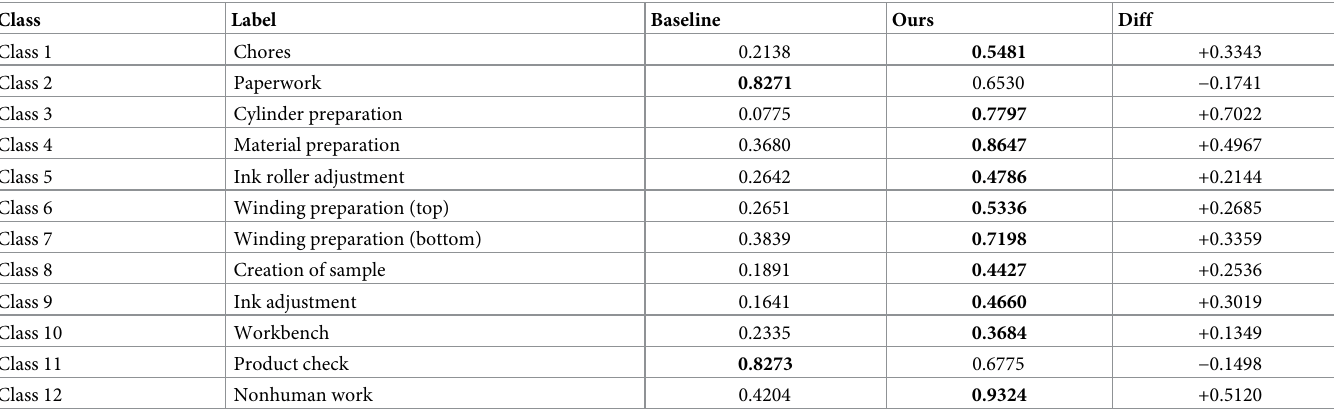
Table 7. Comparison of label-by-label recall between the two LSTM-CNN models (test set). The highest scores are expressed in a bold font.